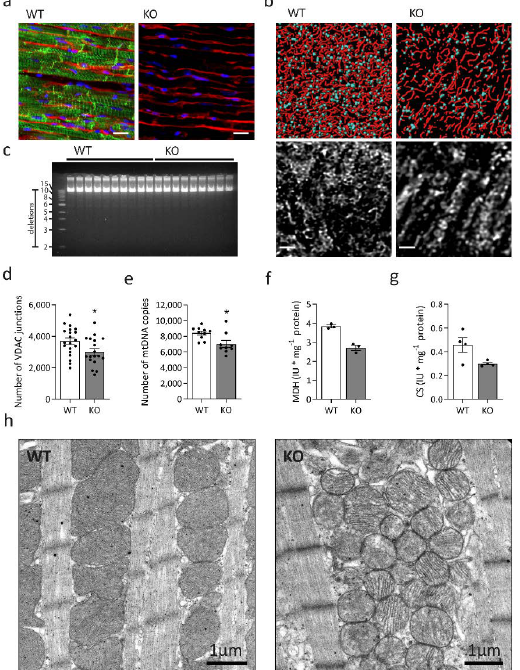
Figure 1. Distribution, number, and ultrastructural morphology of mitochondria in desmin knock-out cardiac tissue. ( a ) Indirect immunofluorescence images of desmin (green) in longitudinal sections of wild-type (WT) and desmin knock-out (KO) ventricular cardiac tissue in conjunction with wheat germ agglutinin conjugate (WGA-AlexaFluor647) as a sarcolemmal marker (red) and nuclear marker DAPI (blue). Scale bars, 20 µ m. ( b ) Analysis of the three-dimensional distribution of mitochondria in left ventricular cardiac tissue. Sections derived from six-month-old desmin knock-out mice (KO) and wild-type littermates (WT) were stained with an antibody directed against the voltage-dependent an- ion channel (VDAC1) (lower panel, greyscale). Confocal Z-stack images from longitudinally oriented cardiomyocytes were processed to visualize the mitochondrial network (upper panel, red). As a surro- gate marker for mitochondrial contact sites, pixels that label crossovers from different mitochondrial fluorescence signals were determined (upper panel, light blue dots). Scale bars, 2 µ m. ( c ) Long-range PCRs from total DNA extracted from left ventricular myocardium derived from desmin knock- out mice and wild-type littermates did not show large-scale mtDNA deletions. ( d ) Quantitation of VDAC1-positive mitochondrial contact sites revealed a significantly reduced number indicating a rarefication of the mitochondrial network in desmin knock-out cardiomyocytes. Five Z-stacked images of different regions of cardiac muscle tissue specimens from each of the four animals of each genotype were analyzed; Mann-Whitney test, * p < 0.05. ( e ) Assessment of mitochondrial DNA (mtDNA) copy numbers by quantitative PCR confirmed a significant decrease in desmin knock-out mice. Samples from nine homozygous and ten wild-type mice were analyzed in nine technical replicates: Mann-Whitney test, * p < 0.05. ( f , g ) Spectrophotometrically determined enzyme activities of malate dehydrogenase (MDH; samples from three animals per genotype analyzed in singlet; Mann-Whitney test, not significant) and citrate synthase (CS; samples from four animals per genotype analyzed in singlet; Mann-Whitney test, not significant) in left ventricular cardiac tissue homogenates were non-significantly reduced in the knock-out condition. Values in ( d – g ) are given as mean ± SEM; ( h ) Electron microscopy depicted areas of focal clustering of mitochondria in conjunction with a marked coarsening of the mitochondrial cristae in the cardiac tissue of desmin knock-out mice (KO) as compared to the wild-type